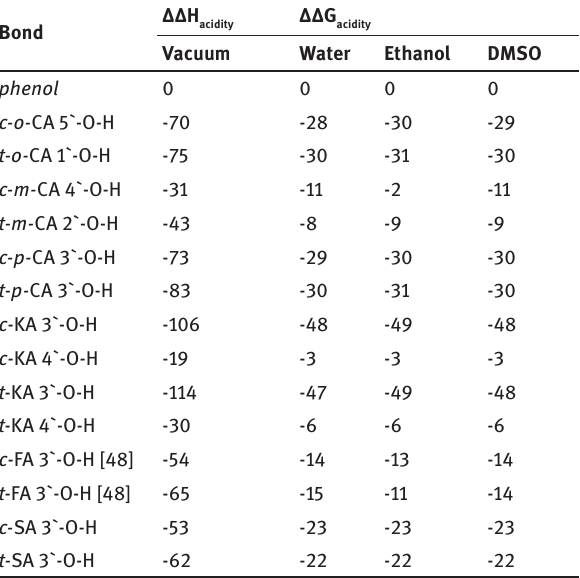
and ∆∆G values [kJ mol -1 ] calculated with Table 7: ∆∆H acidity acidity B3LYP/6-311++G(2d,2p) level of